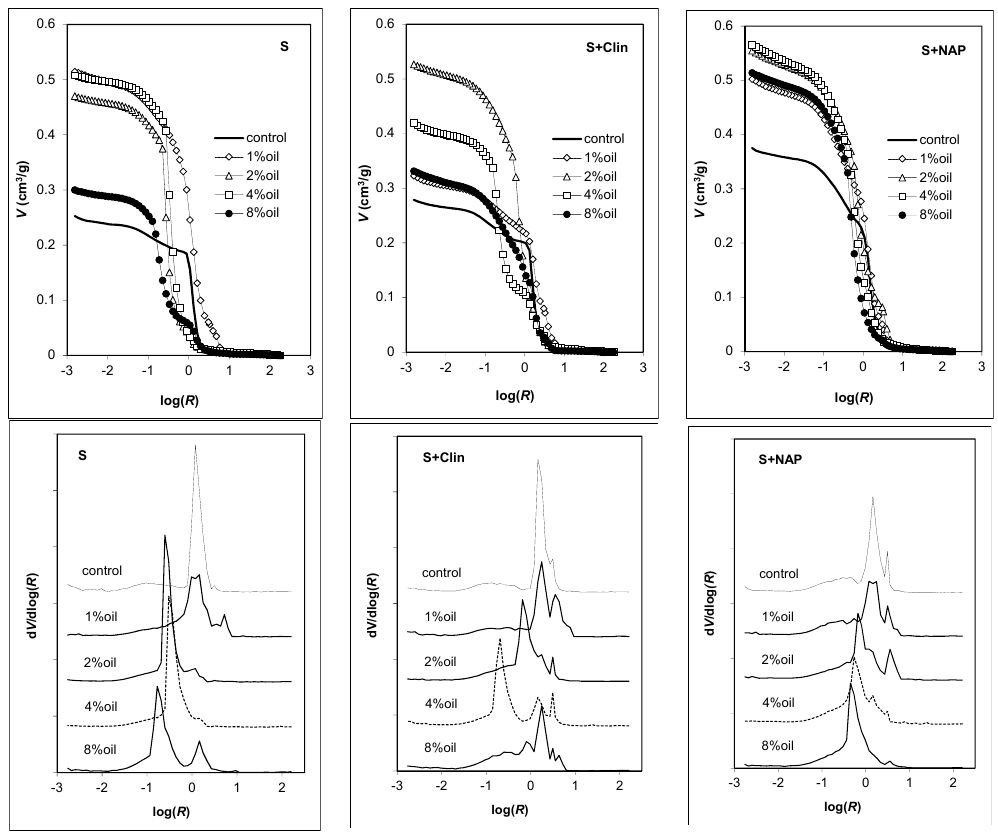
Figure 6. Mercury intrusion porosimetry curves ( up ) and normalized pore size distribution functions ( down ) for the studied aggregates. The average results for the experimental replicates are plotted. The unit of R is µm.